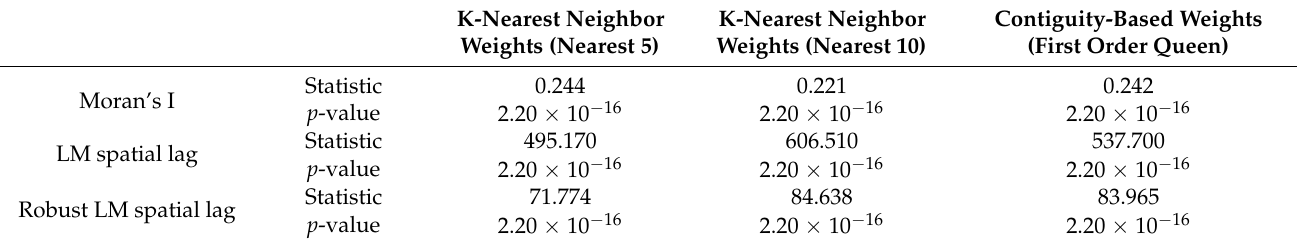
Table 2. Tests for Spatial